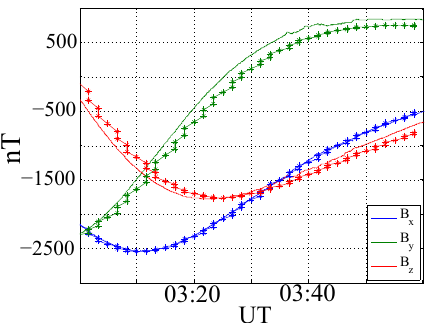
Figure 7. Magnetic field in GSE coordinates from Tsyganenko model (stars) and Cluster 3 FGM instrument, for 17 July 2008.